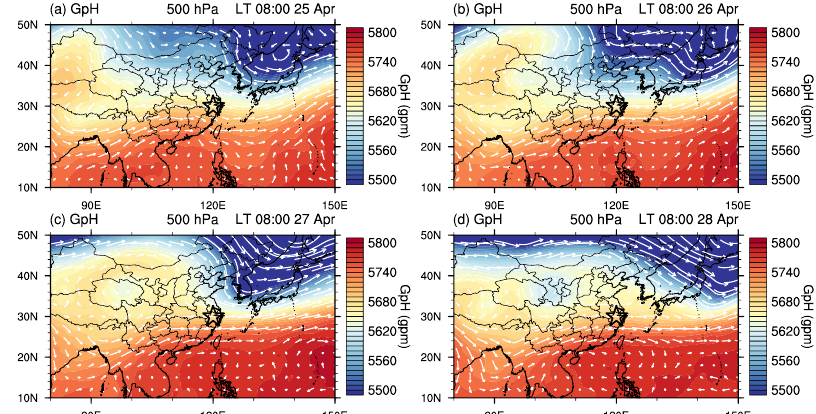
Figure 5. Spatial distribution of geopotential height (shading) and horizontal winds (arrows) at 500 hPa over east Asia from 25 April 2018 to 28 April 2018. The geopotential height and horizontal winds data are from ERA5. The black star in each panel indicates the area of interest of this study.